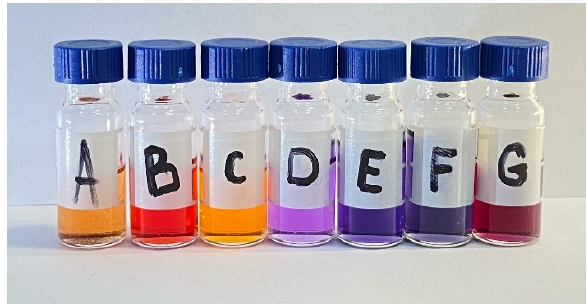
Figure 5. CH 2 Cl 2 solutions of 3a – 3g .